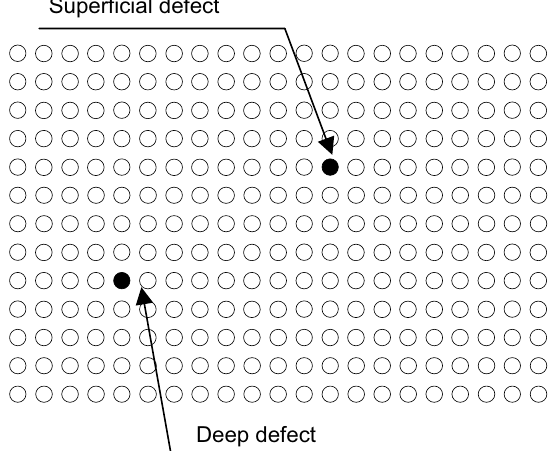
Fig. 10. ANN output related to experimental data of the aluminium plate.